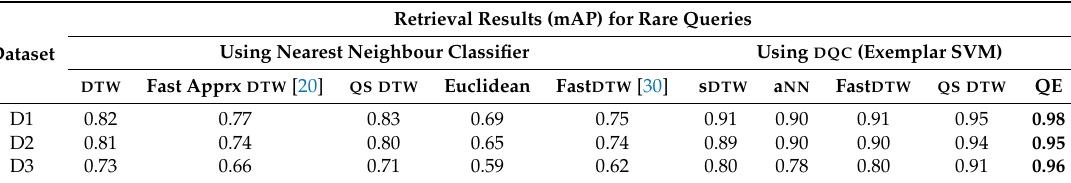
Table 4. Retrieval performance of various methods for rare queries.